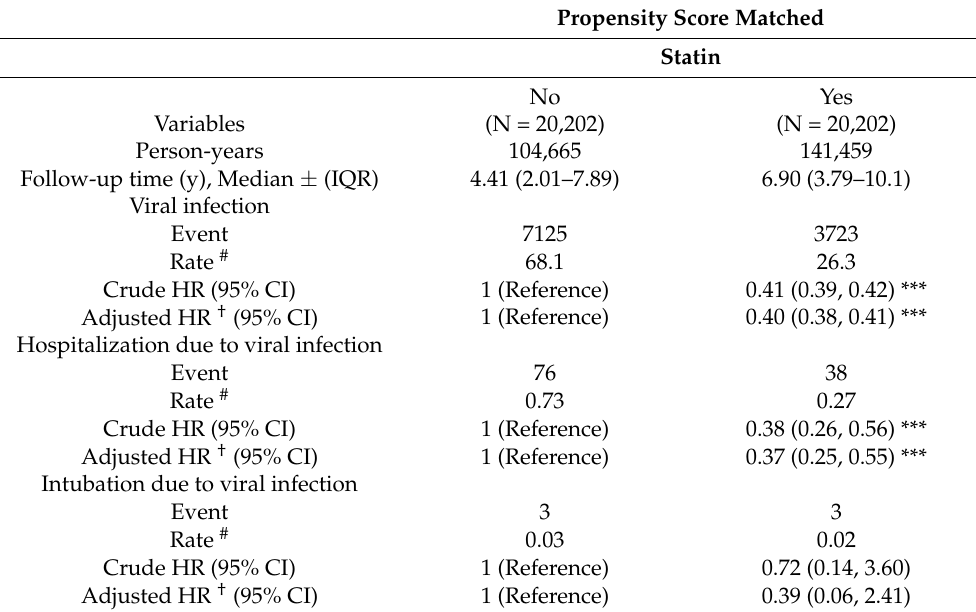
Table 2. Incidence (per 1000 person-years) of viral infection and the estimated Cox proportional hazards ratios of statin users to nonusers based on time-dependent exposure covariates in patients with hyperlipidemia.